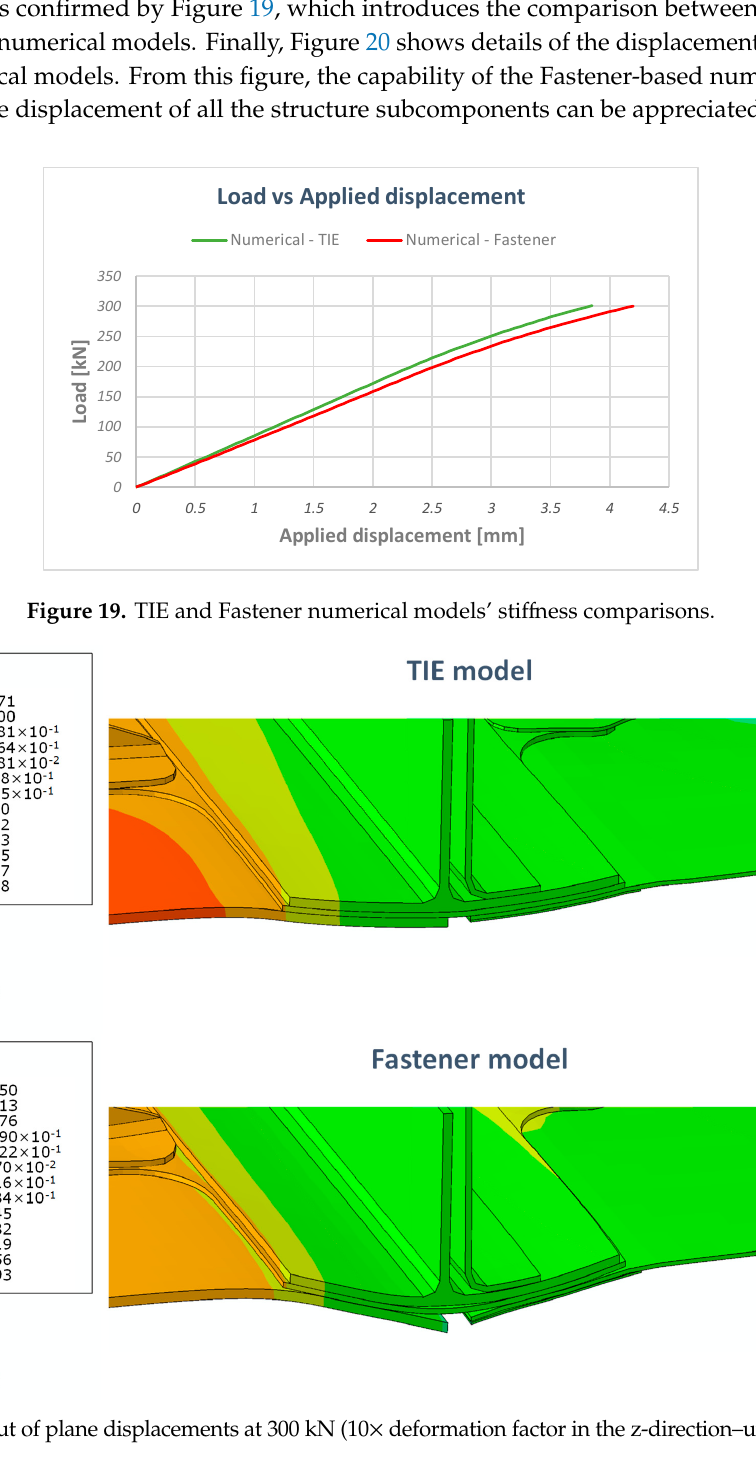
Figure 20. Out of plane displacements at 300 kN (10× deformation factor in the z-direction–units in mm).